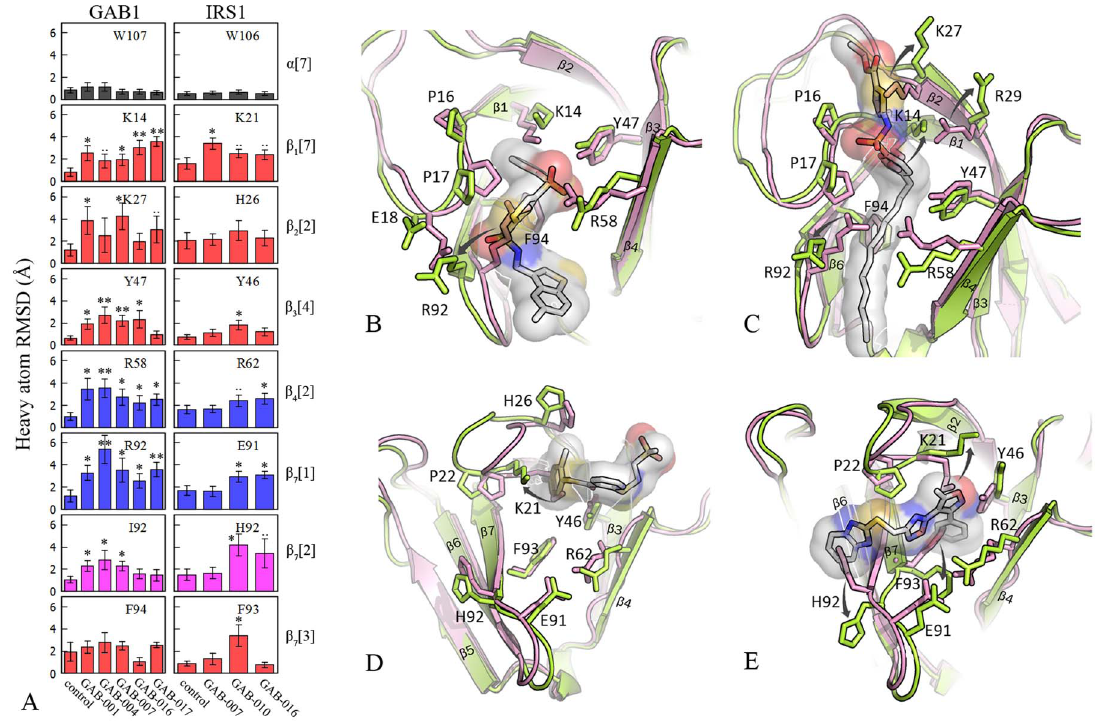
Fig. 7. Inhibitor-induced conformational changes for PH domain structures. A . Heavy atom RMSDs for the residues with conformational changes. RMSD of each residue is calculated from the snapshots taken from three independent MD simulations and compared with the unbound control structure. W107 GAB 1 and W106 IRS 1 (in black) are used as the controls for no conformational change. Red: Region I residues; Blue: Region II residues; Magenta: Region III residues. ‘‘..’’ for p , 0.1; ‘‘*’’ for p , 0.05; ‘‘**’’ for p , 0.01. B–E . The critical residues in the three regions are shown in sticks. Pink: the protein in unbound state; Green: the protein in inhibitor-bound state. The inhibitors are depicted with gray sticks and surfaces. The arrows illustrate large conformational changes. B. GAB1 PH domain in complex with GAB-001; C. GAB1 PH domain in complex with GAB-017; D. IRS1 PH domain in complex with GAB-007; E. IRS1 PH domain in complex with GAB-010.